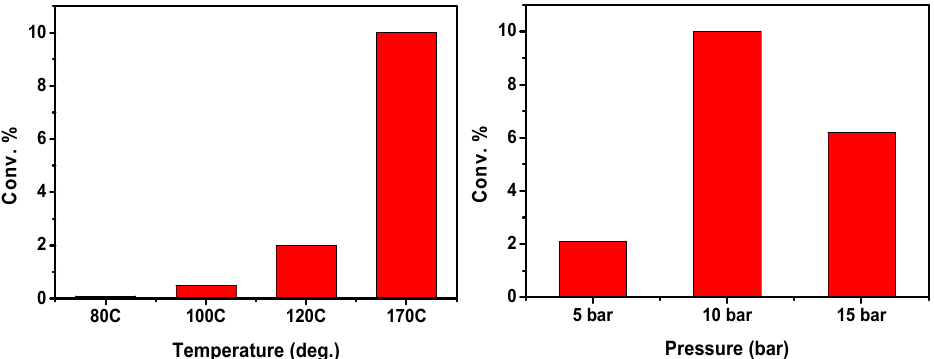
Figure 5. Left panel: effect of H 2 pressure on the MIBK conversion % at 170 ° C over Pd-CsPW. Right panel: effect of reaction temperature on the conversion of MIBK over Pd-CsPW under 10 bar H 2 .